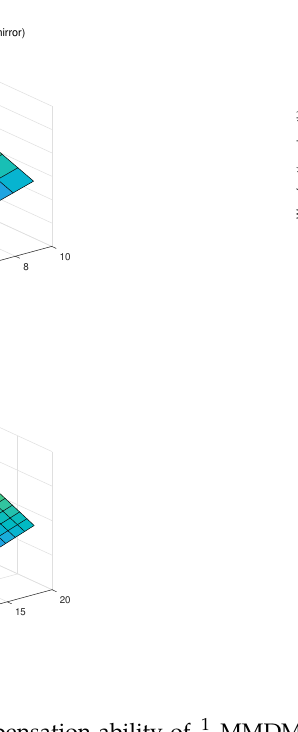
MMDM for tilts aberrations. ( b ) Theoretical 4